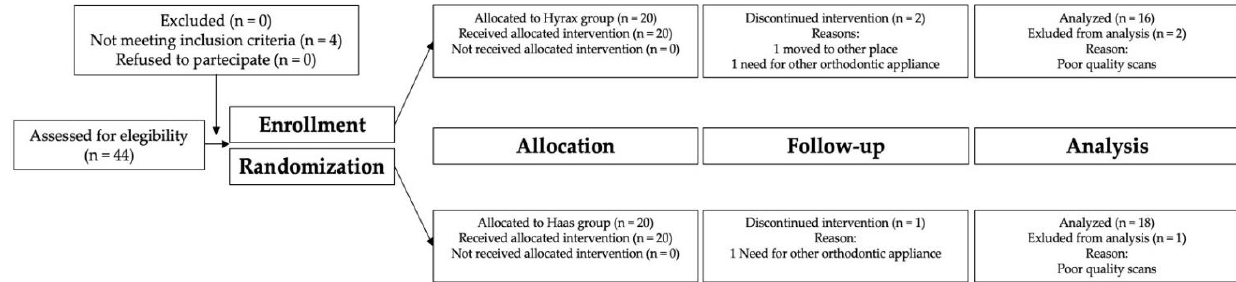
Figure 1. Flow diagram of patient selection according to consort statement. Palatal expanders were composed of two bands bonded on second deciduous molars and with palatal extensions bonded onto deciduous canines. The expander’s screw was initially activated and turned twice (0.45 mm initial activation) during the first appointment. Afterwards, it was turned once per each of the following day (0.225 mm activation/day). Maxillary expansion was performed until dental overcorrection, defined as when the lingual cusps of the upper first molars occluded onto the buccal cusps of the lower first molars, was achieved. The screw was then locked, and the expander was kept on the teeth as a passive retainer. During this period, none of the patients underwent any further orthodontic treatment. The mean activation and retention times were 3 ± 1 months (range 1–5 months) and 10 ± 2 months (range 6–12 months), respectively. CBCTs and dental casts were taken before (T0) and after treatment (T1). Ultra low dose 3D imaging protocol and adjusted field of view (FOV) were used to respect ALARA principle (Planmeca ProMax 3D Mid; Planmeca, Helsinki, Finland). The entire treatment lasted a mean time of 13 ± 3 months (range of 9–13 months). CBCT scans were traced, and data was subsequently recollected by the same expert orthodontist (C.V.). DICOM files were processed using Mimics Software (version 10.11, Materialise Medical Co, Leuven, Belgium) and exported in IGES format for both right and left sides. For each CBCT image, skeletal and dental landmarks were taken using a coordinate system previously proposed in a similar study [17]. ELSA (midpoint of line connecting both foramen spinosum landmarks) was set as x, y, and z origin and corresponding coordinate planes (x: coronal; y; sagittal; z: axial) that started from ELSA point passing through RPo (Right auditory external meatus) and LPo (Left auditory external meatus) points was constructed. Table 1 summarizes the landmark’s definition and their